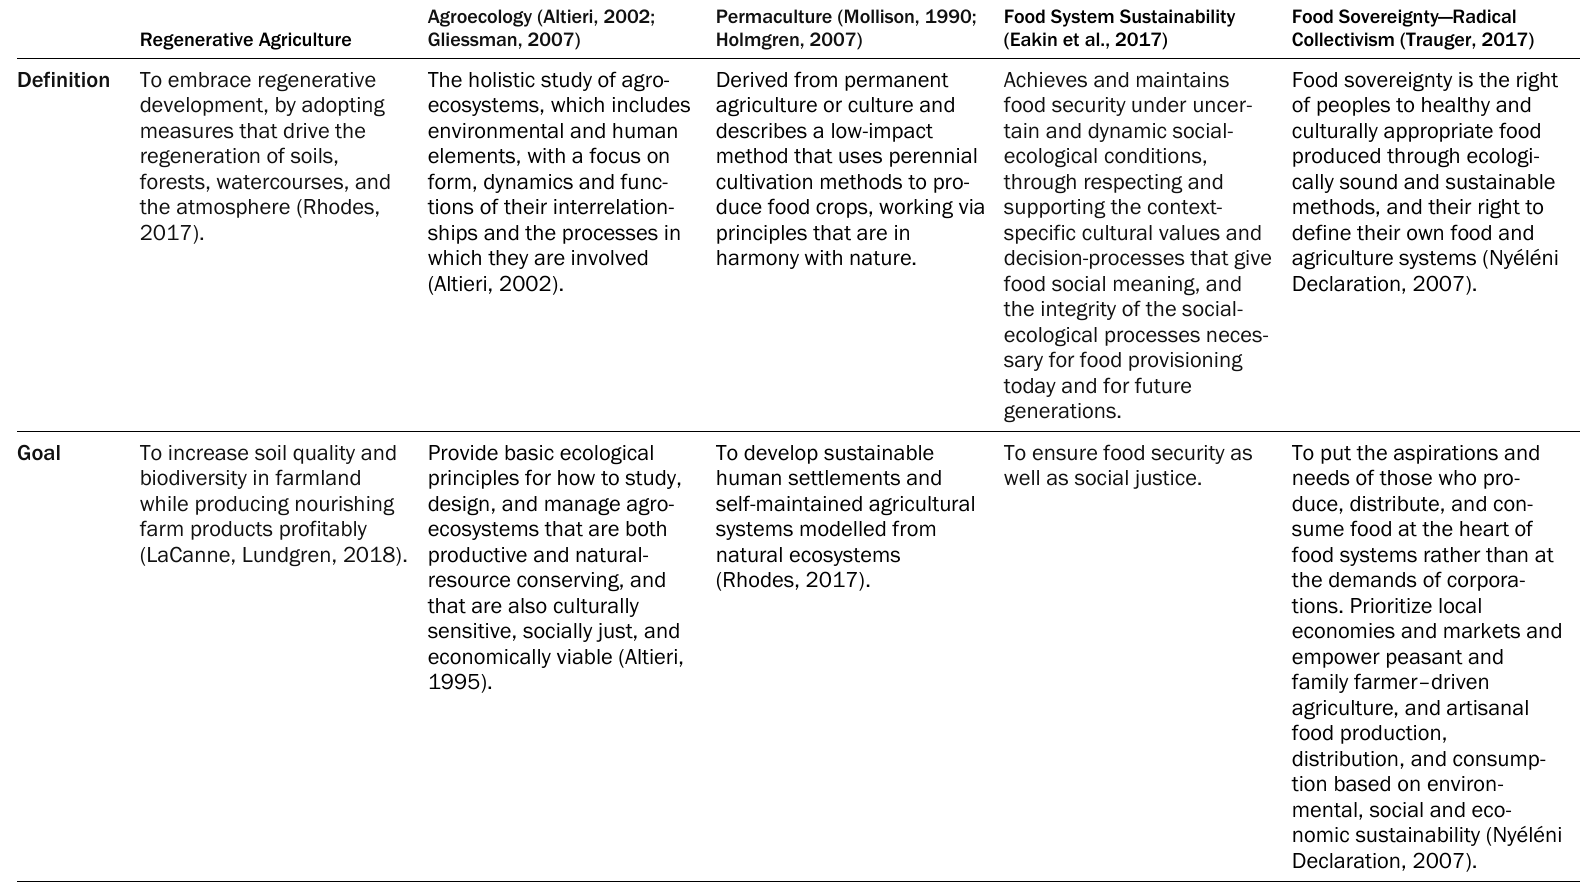
Table A1. Comparing Regenerative Agriculture, Agroecology, Permaculture, Food System Sustainability and Food